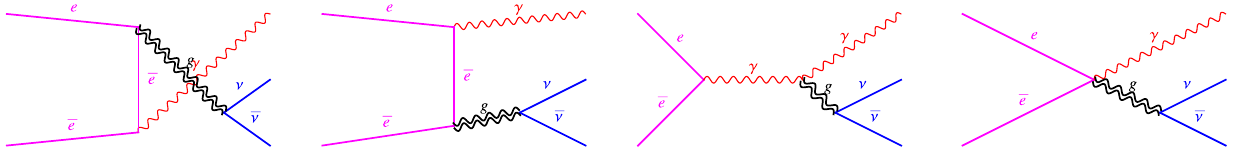
Fig. 1 Sample of gravi-ghost-mediated 2 → 3 process: the differential distribution of σ( e ¯ e → γν ¯ ν) is used to infer the cross section for σ( e ¯ e → γ g